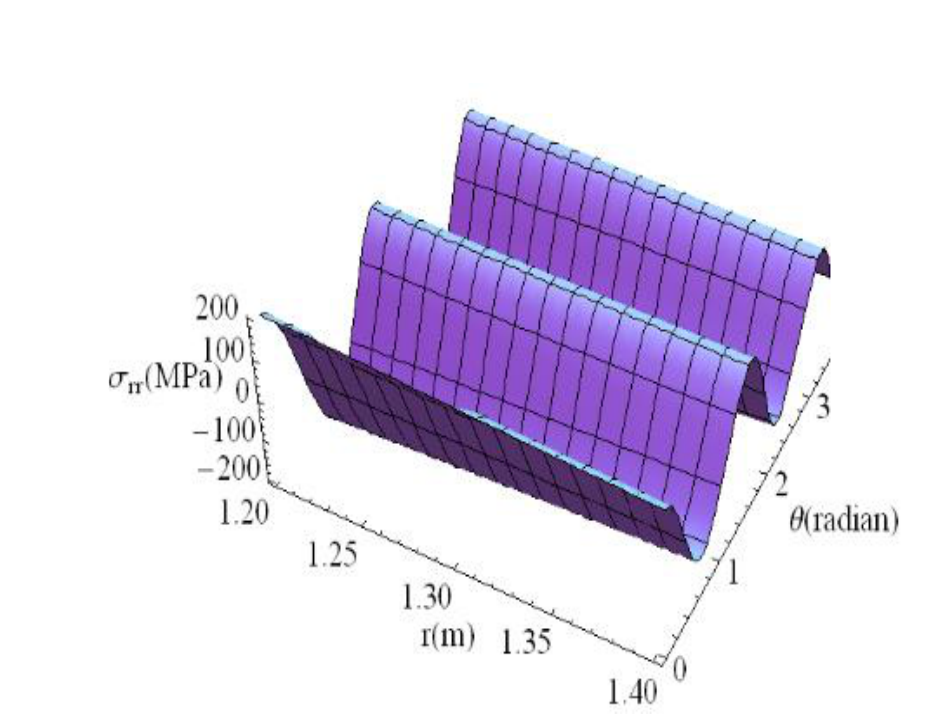
Figure 4. Radial stress at 𝛽 = 2 .